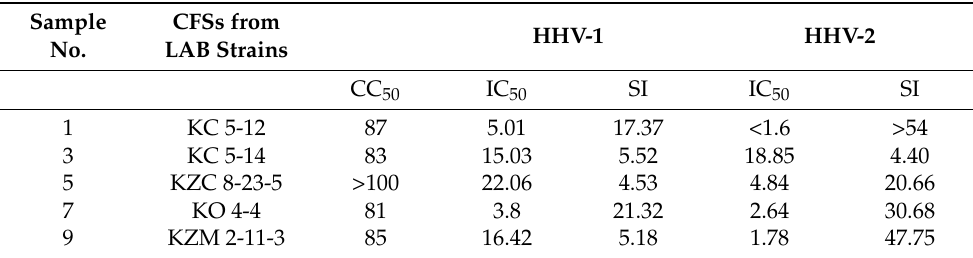
Table 2. Antiviral activity of CFSs from the studied LAB strains HHV-1 and HHV-2 and determination of selective